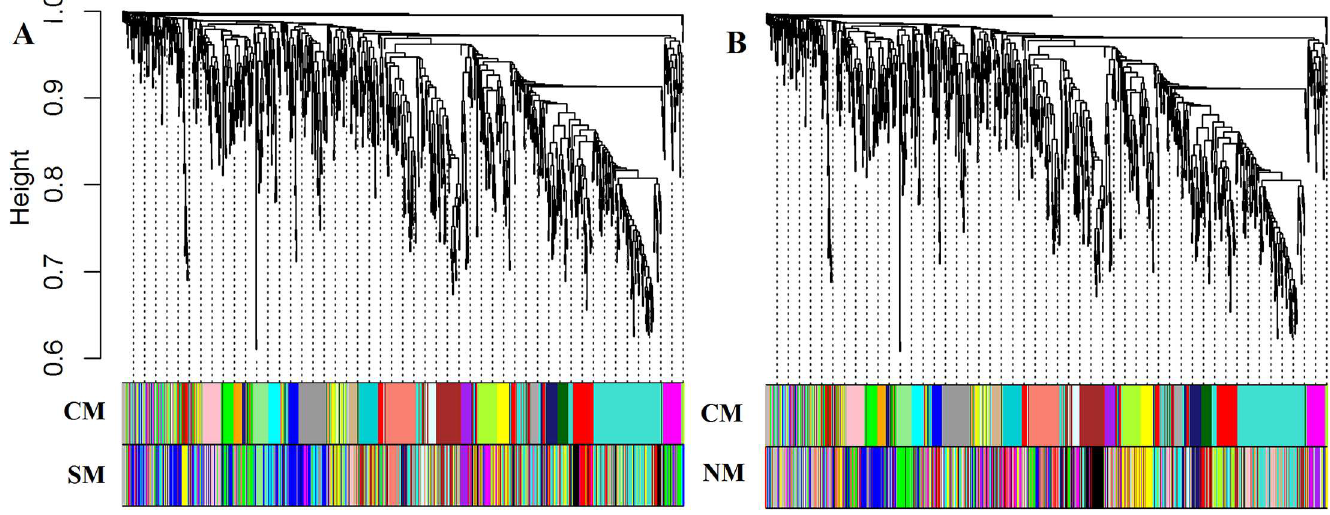
Fig 3. Clustering dendrogram of selected genes and gene modules under Al stress and control condition. The correspondence between Consensus Modules(CM) with modules under Stress (SM) (A) and control (NM) (B) conditions is represented.